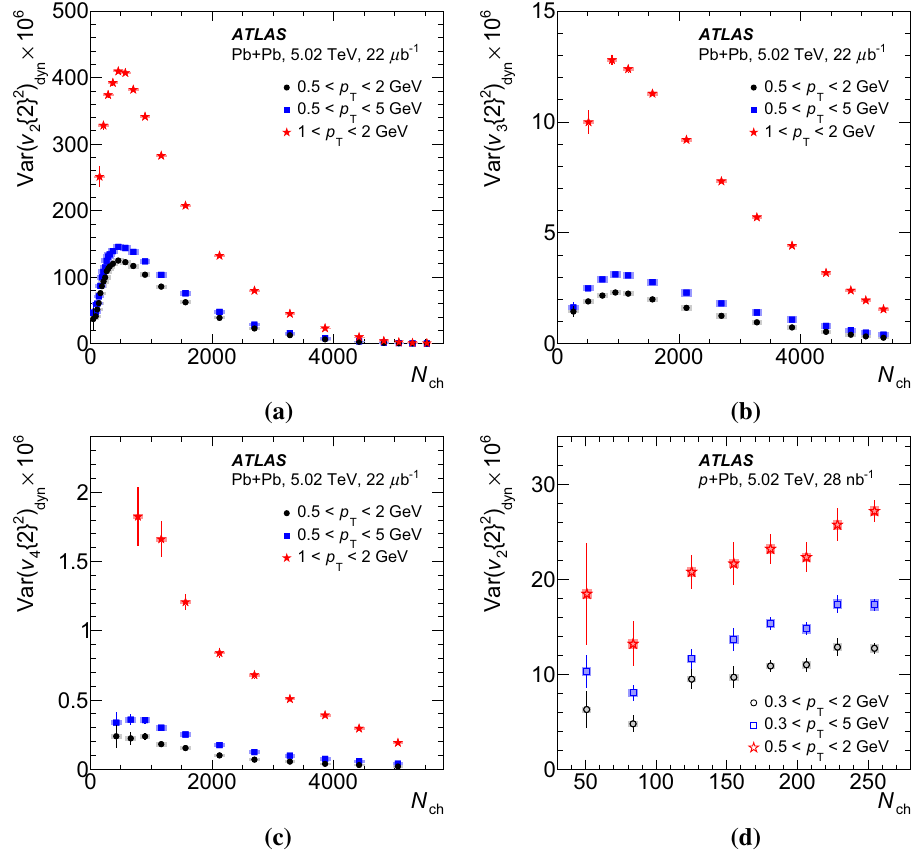
Fig. 3 The variance (cid:4) (cid:3) v { 2 } 2 Var for n = 2 − 4 n dyn for a – c Pb+Pb collisions and (cid:3) (cid:4) { 2 } 2 v for d p +Pb Var 2 dyn collisions for the three p T intervals as a function of charged-particle multiplicity N ch . The statistical and systematic uncertainties are shown as vertical error bars and boxes, respectively